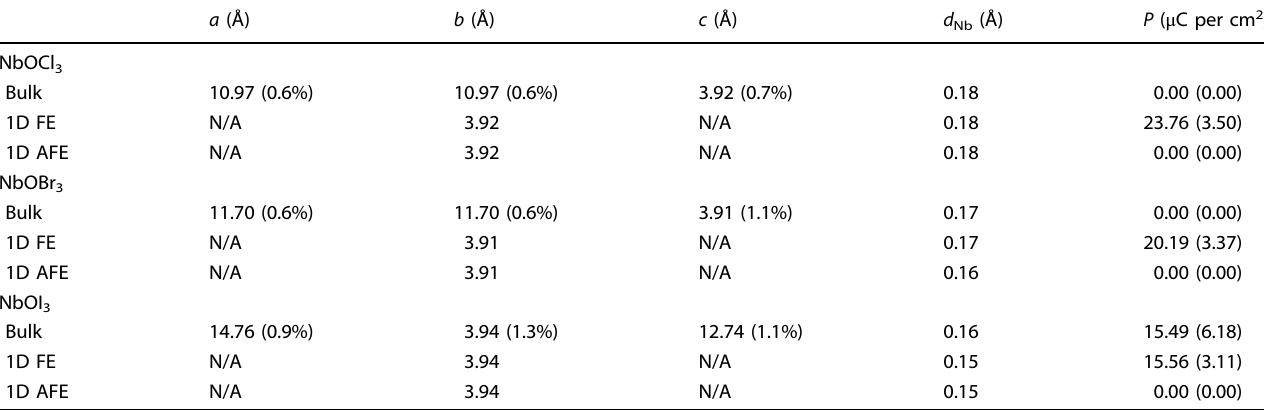
For bulk NbOX 3 , the differences between calculated lattice parameters and the experimental values are shown in parentheses (in percent). The P (in eÅ per unit cell) is also given in parentheses for clarity. Note that bulk NbOI 3 contains two 1D nanowires in its unit cell thus its P (in eÅ per unit cell) is around twice than that of 1D FE NbOI 3